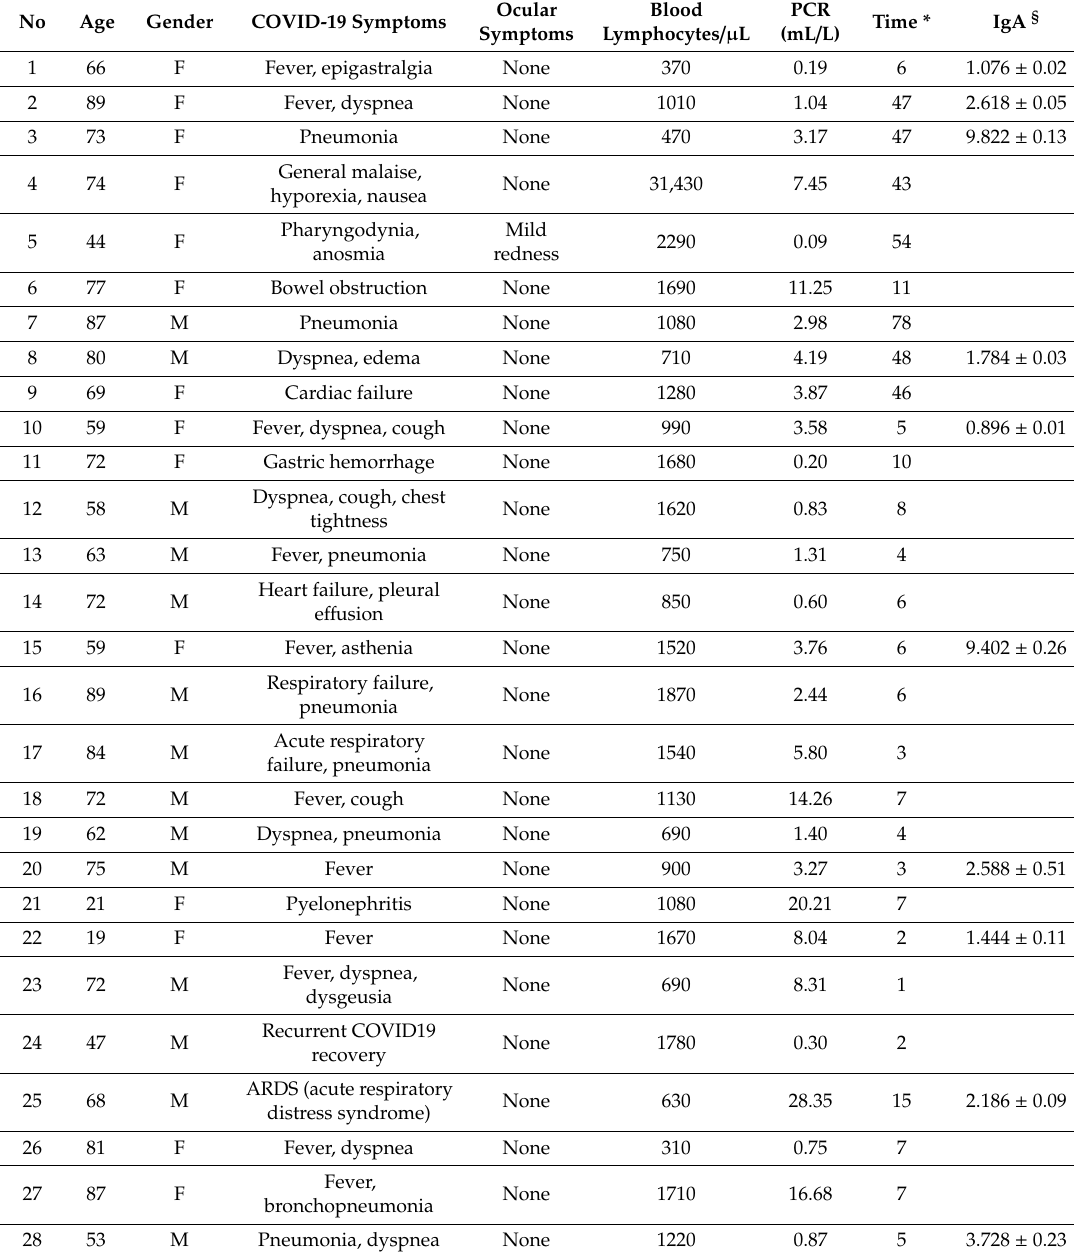
Table 1. Clinical characteristics and ocular IgA detection in recruited COVID-19